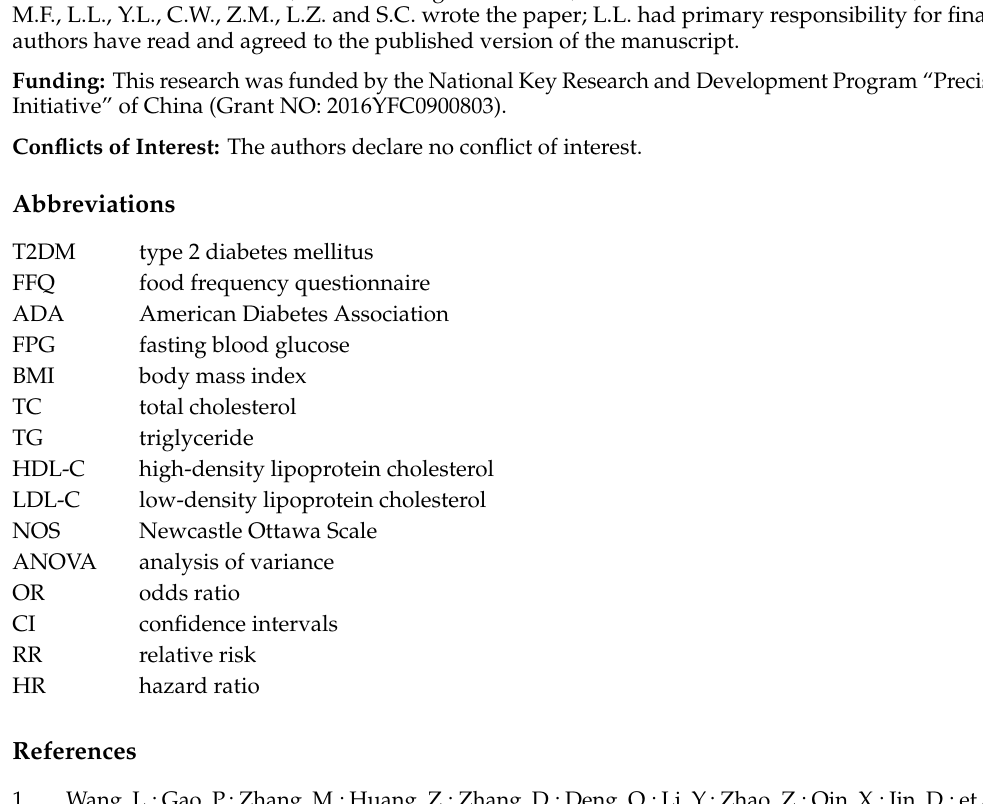
Table S1: Search terms in meta-analysis of association between total dairy and type 2 diabetes mellitus; Table S2: Type 2 diabetes mellitus according to total dairy intake: stratified analyses of the Henan Rural Cohort Study; Table S3. ORs of T2DM according to servings per day of dairy products ( n = 38,735) of the Henan Rural Cohort Study; Table S4: Characteristics of included studies of total dairy consumption and type 2 diabetes mellitus of the meta-analysis; Table S5: Quality assessment of cohort studies included in meta-analysis (Newcastle–Ottawa Quality Assessment Scale); Table S6: Dose–response meta-analysis for per 100 g / day increase in total dairy and risk of type 2 diabetes mellitus, stratified by study design, gender, age, follow-up, geographic location, number of cases of high vs. low intake; Figure S1: Flow diagram of the meta-analysis; Figure S2. Prospective associations of dairy intake with incident type 2 diabetes mellitus for dose–response analysis of the meta-analysis; Figure S3: Funnel plots of dairy intake–T2D associations (high vs. low meta-analysis) SE = Standard error; Figure S4: Funnel plots of dairy intake–T2D associations (dose–response meta-analysis) SE = Standard